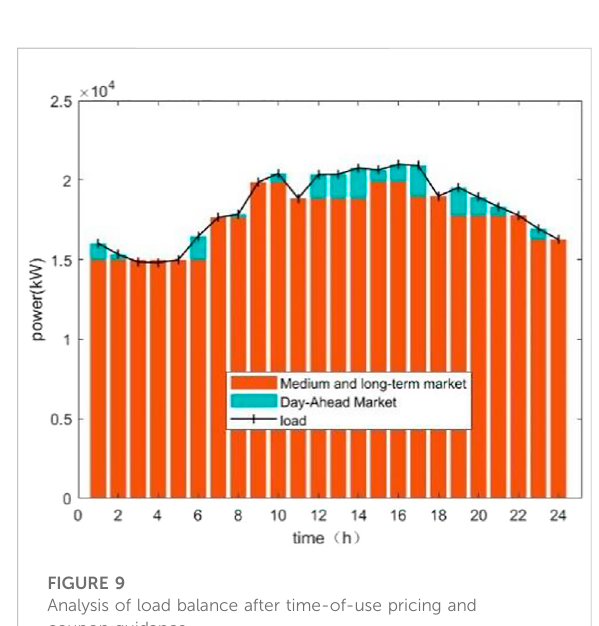
FIGURE 9 Analysis of load balance after time-of-use pricing and coupon